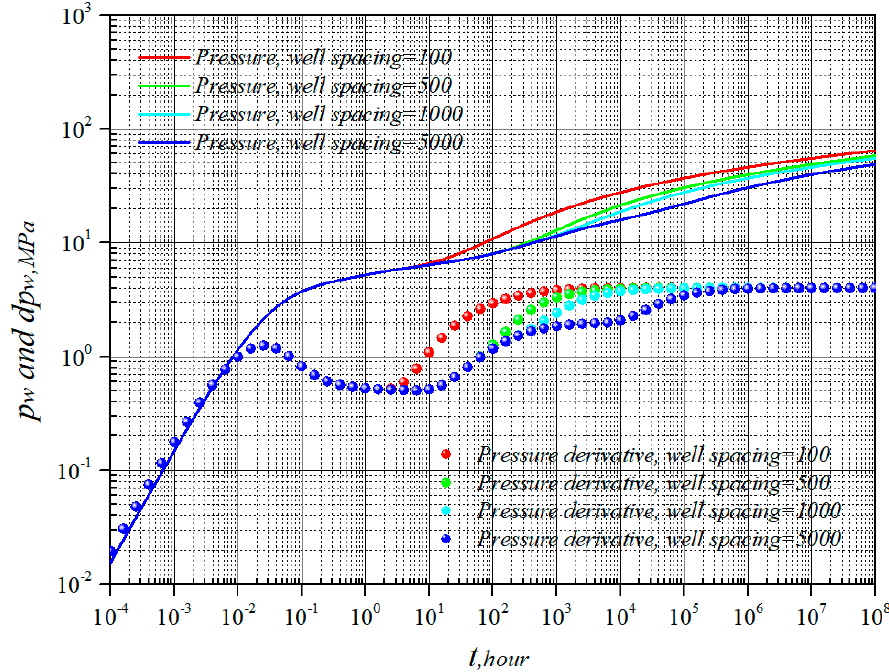
Figure 6. Effect of well spacing on the tested well’s pressure behaviors in the multi-well system.